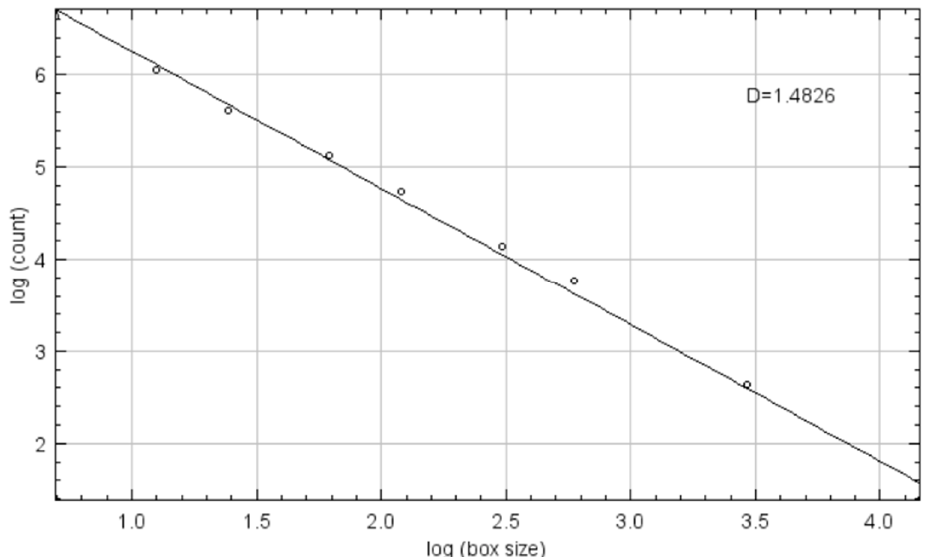
Figure 2. Logarithm of N(r) versus logarithm of r diagram.